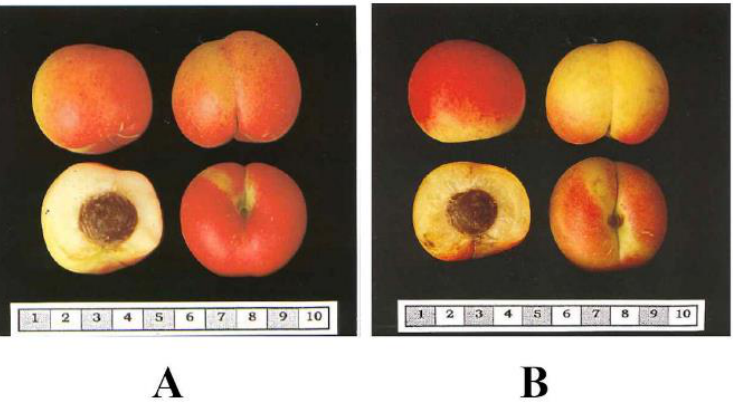
Figure 2. Examples of apricot fruits from Mediterranean varieties used as genitors in the breeding program with high red-blush on the skin. This trait is related to anthocyanin content. ( A ). Fruits from ‘Ginesta’ ( B ). Fruits from ‘Palau’.